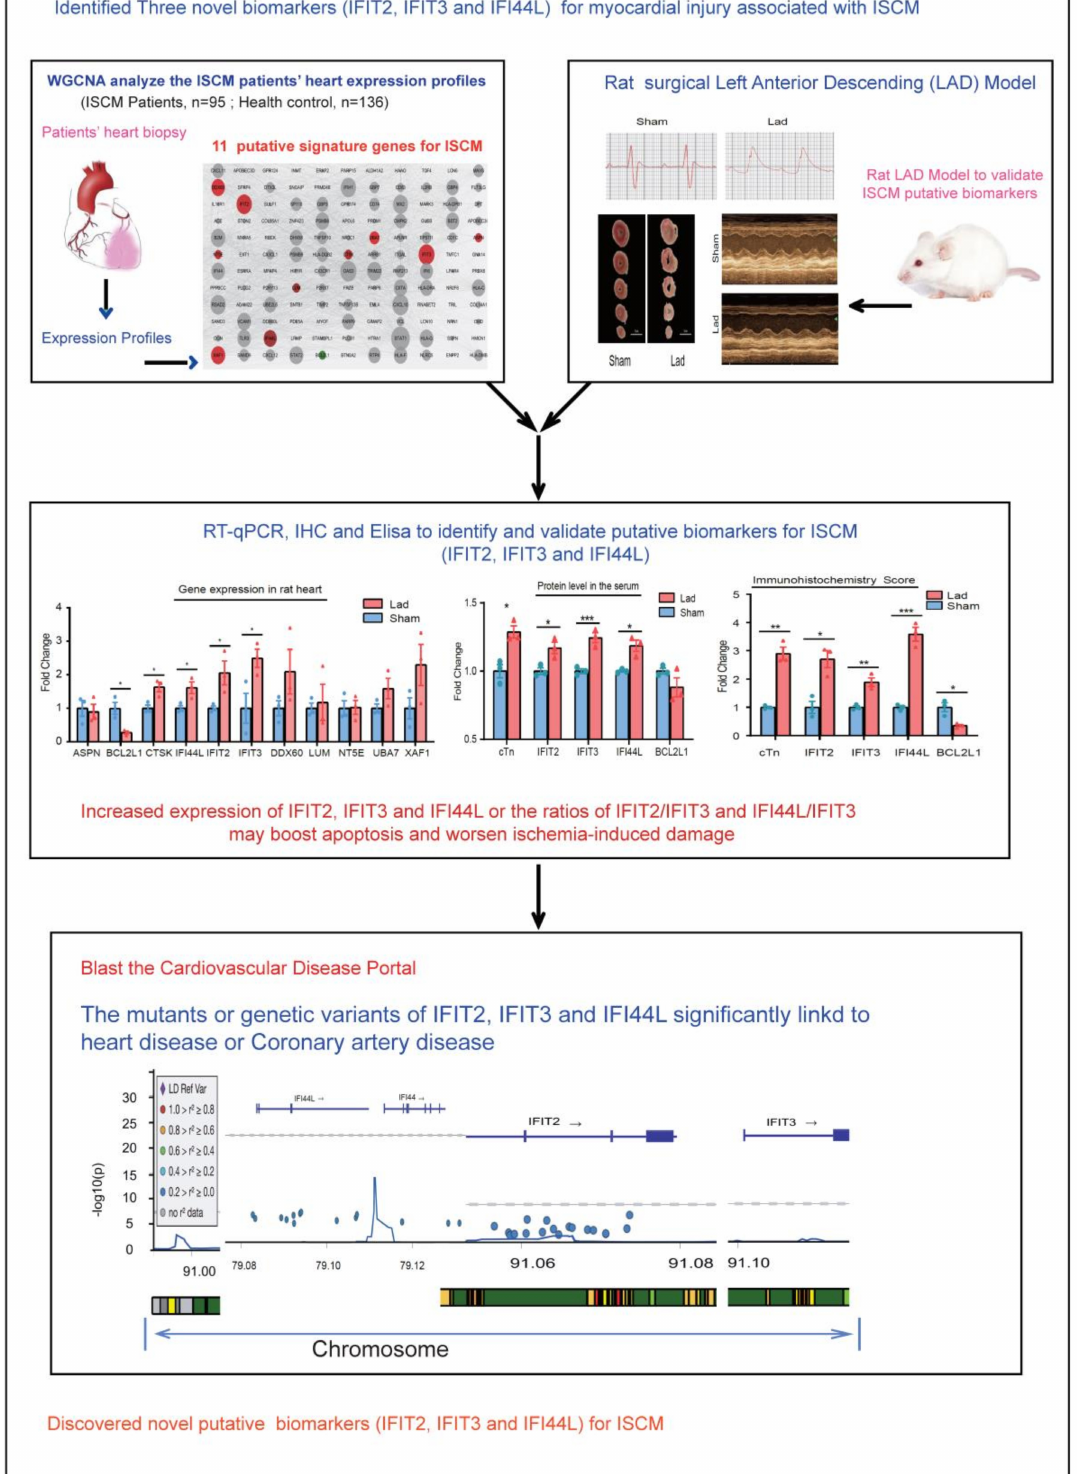
Figure 1. Overview workflow of the data analysis and experimental design. *, p < 0.05; **, p < 0.01; ***, p <